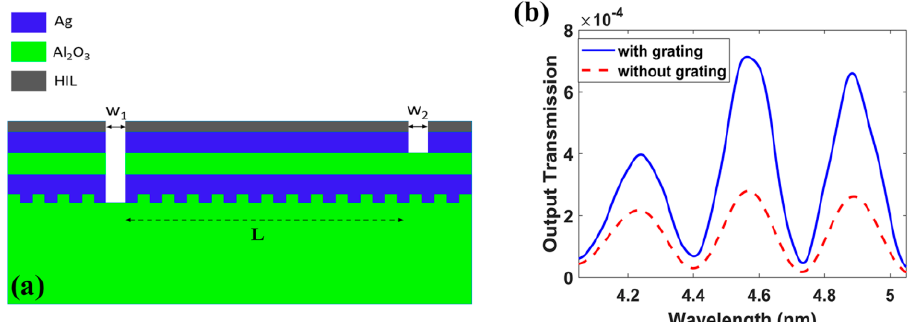
Figure 12. Vertical plasmonic gas sensor MZI with high index layer and grating ( a ) Structure, ( b ) Normalized Output transmission versus wavelength with grating P gr = 1216.2 nm, h gr = 475 nm and without grating with D = 900 nm, T = 1500 nm, h HIL = 240 nm, w 1 = 1550 nm, w 2 = 1600 nm and L = 250 µ m [115].